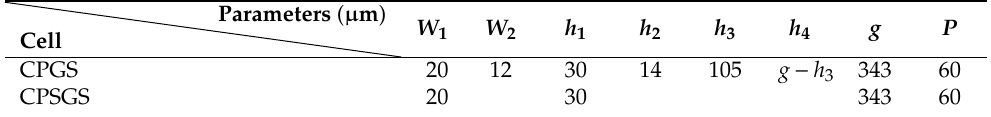
Table 1. The geometric dimensions of unit